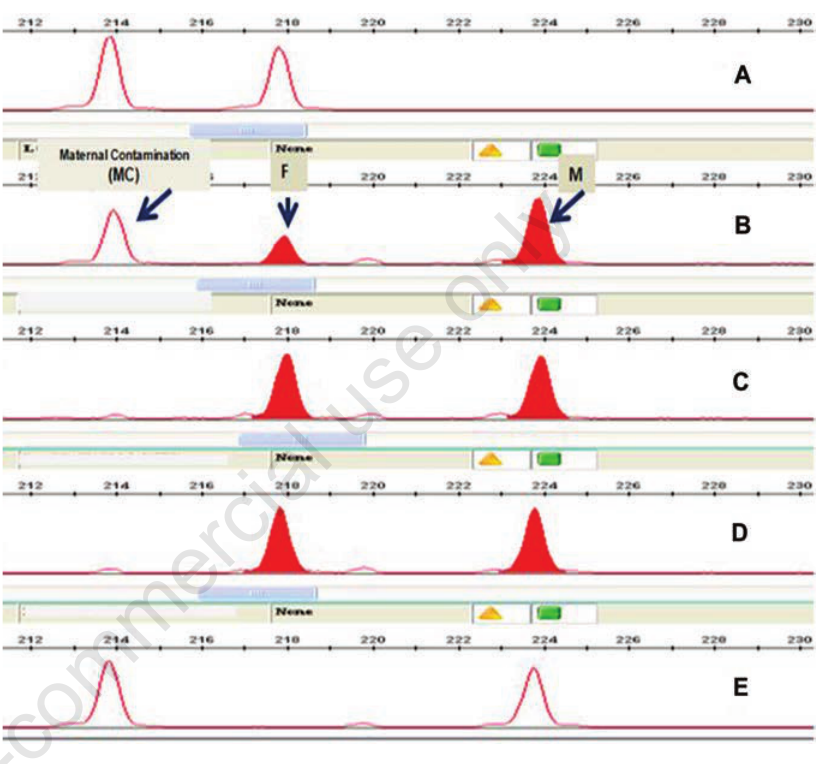
Figure 4. Contamination control by parents’ alleles quantitative fluorescent polymerase chain reaction valuation: A) father; B) coelomatic fluid before antibodies selection; C)